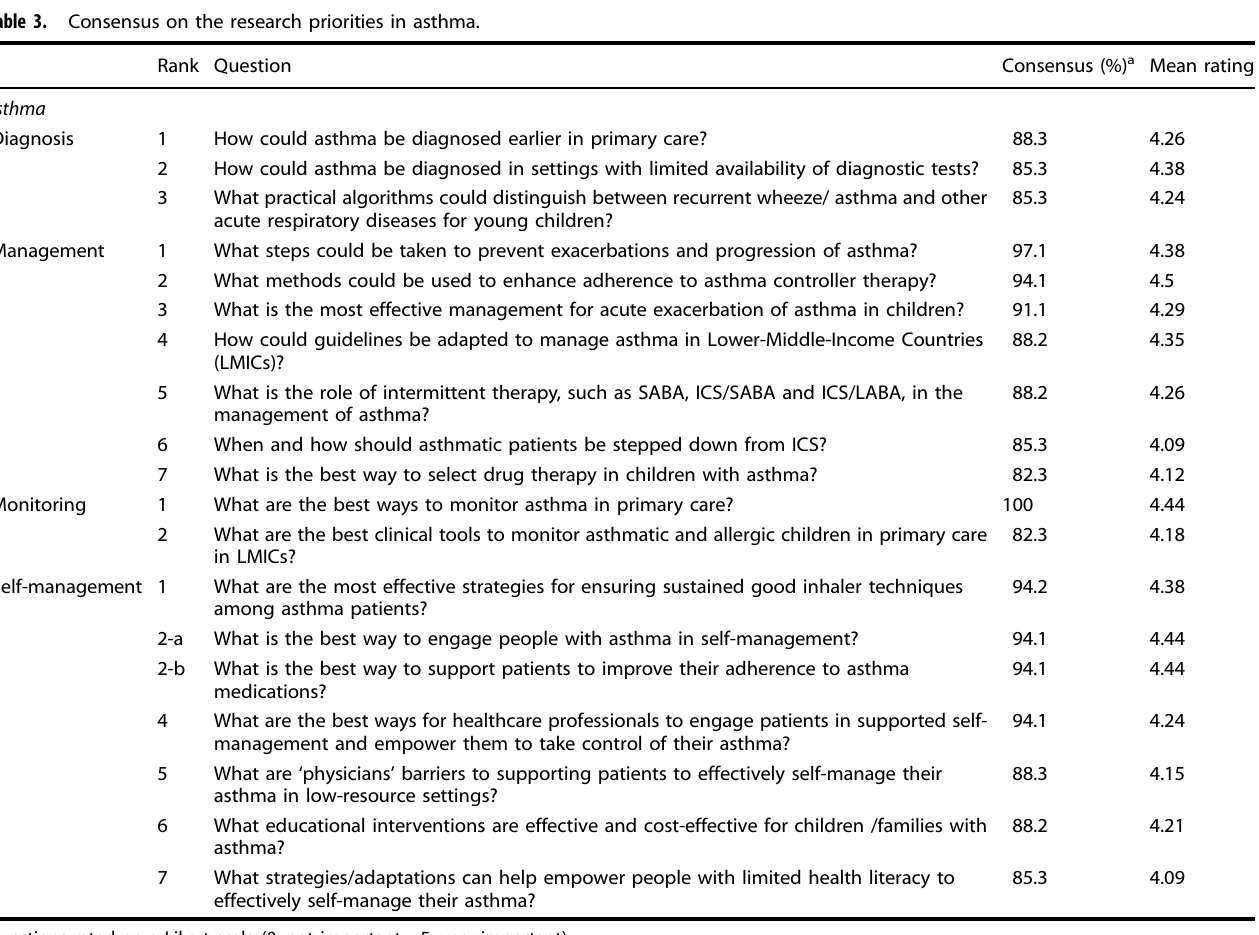
Table 3. Consensus on the research priorities in asthma.